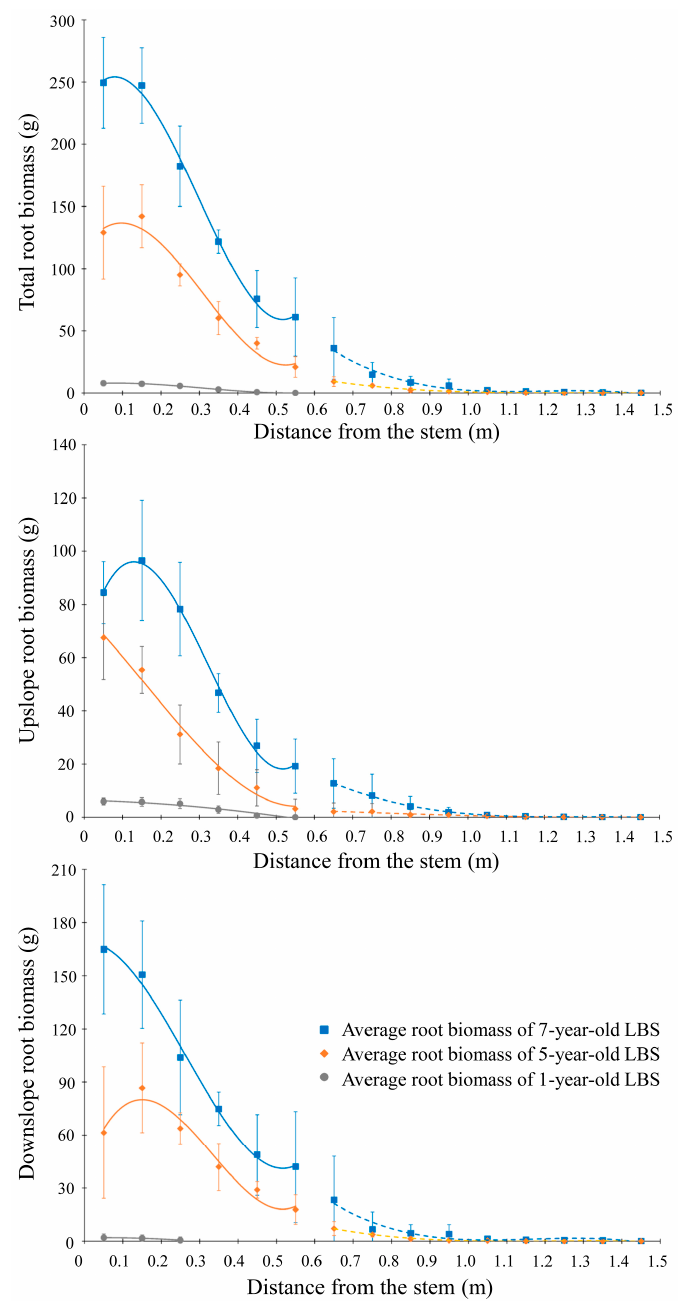
Figure 8. Average root biomass distribution with distance from the stem for 1-, 5- and 7-year-old LBS. The fit curves of root biomass with depth by regression analysis are also shown. The solid lines represent the fitted curves of the active layers. The dotted lines represent the fitted curves of the stable layers.